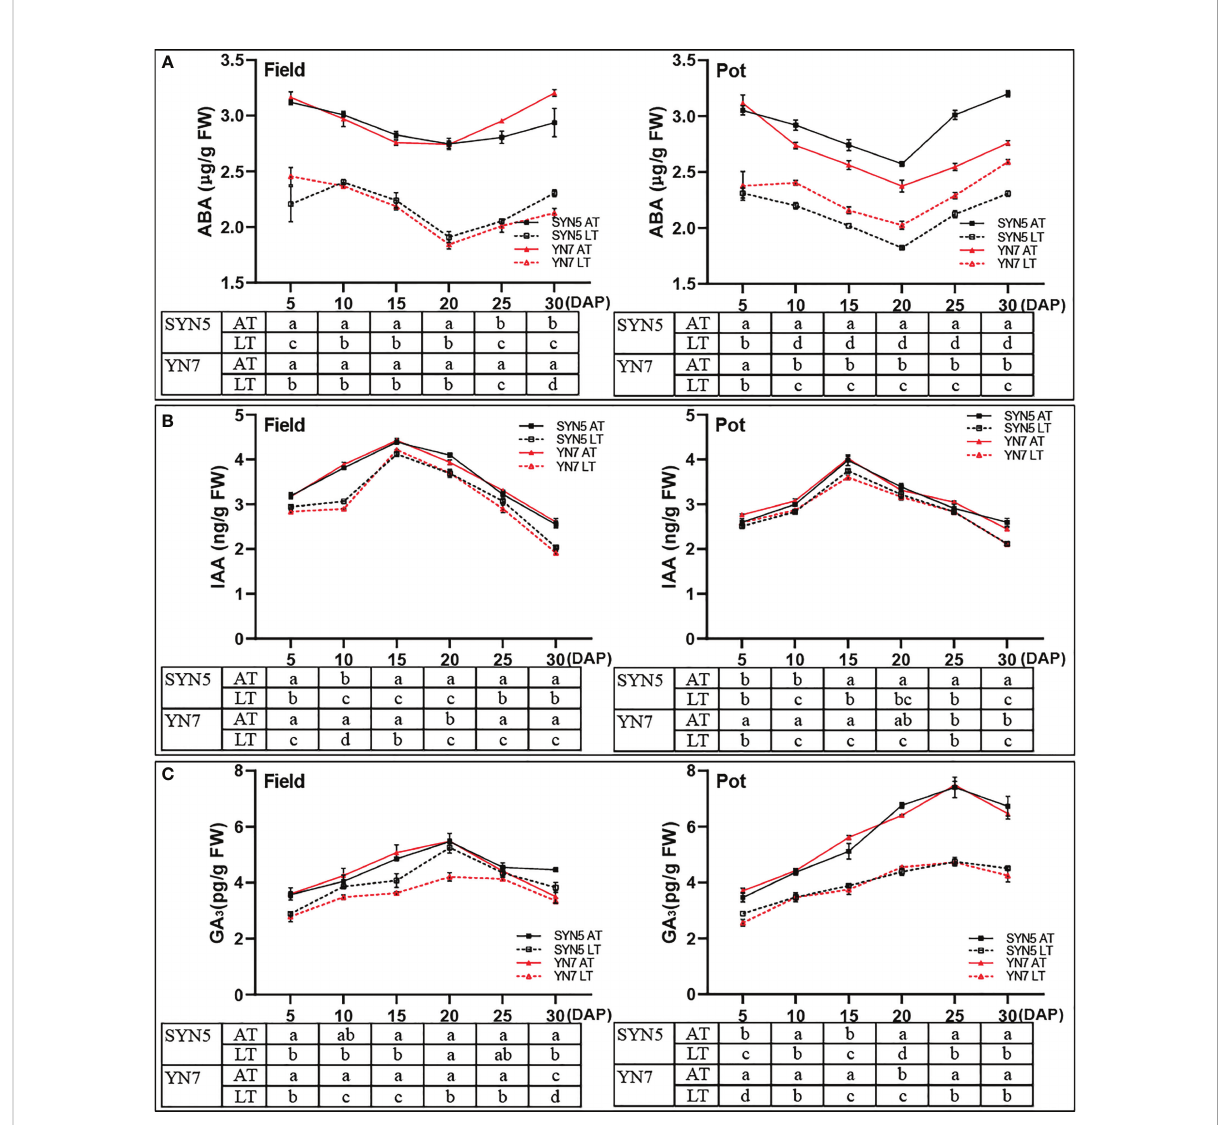
FIGURE 6 Effect of post-silking LT on the contents of endogenous hormones in grains during grain fi lling stage. (A) , ABA (abscisic acid); (B) , IAA (indole-3- acetic acid); (C) , GA 3 (gibberellin 3). Error bars denote standard errors from three replicates, and different letters at the same sampling date indicate signi fi cant difference at P <